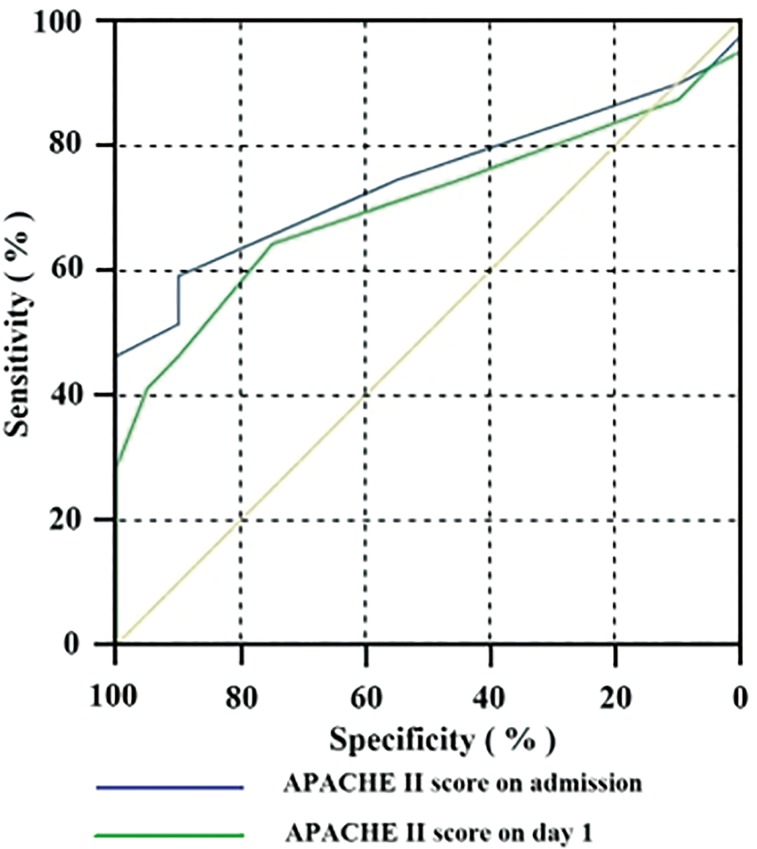
ROC curve of APACHE II score on admission versus APACHE II score on day 1 in predicting POF.